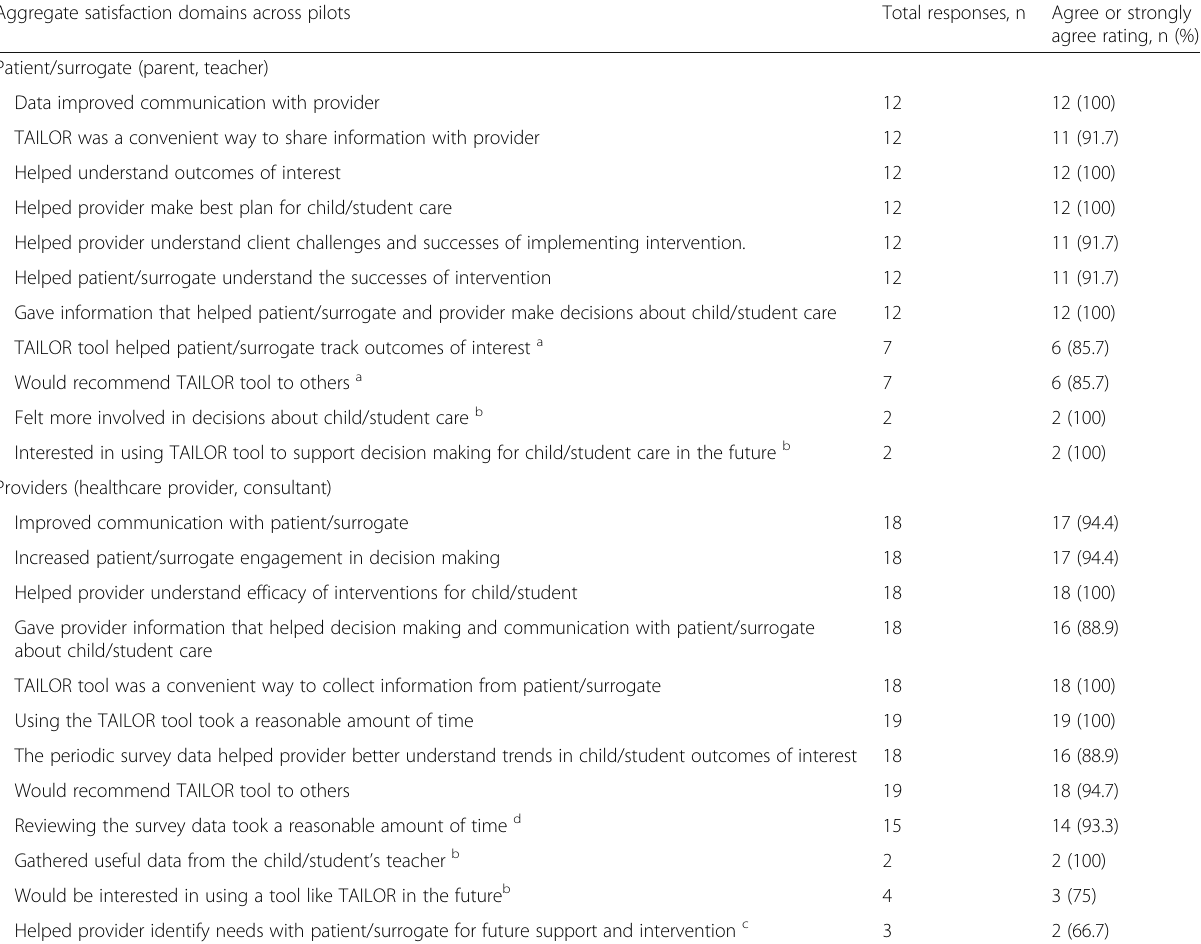
Table 3 Patient/surrogate and provider assessment of satisfaction with the TAILOR tool Aggregate satisfaction domains across pilots Total responses, n Patient/surrogate (parent,